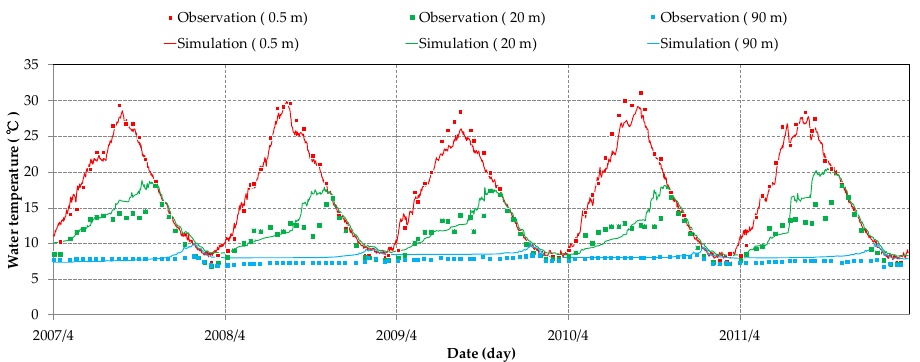
Figure 5. Time series of observed and simulated water temperature at depths of 0.5 m, 20 m, and 90 m at the monitoring point in Imazu-oki.